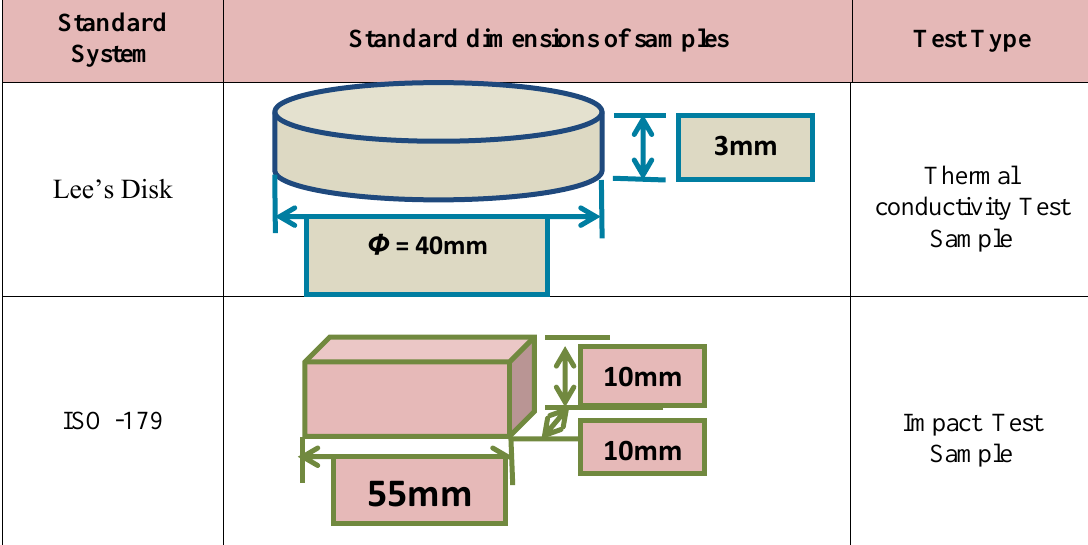
Table 1: Standard dimensions of thermal conductivity and Impact strength